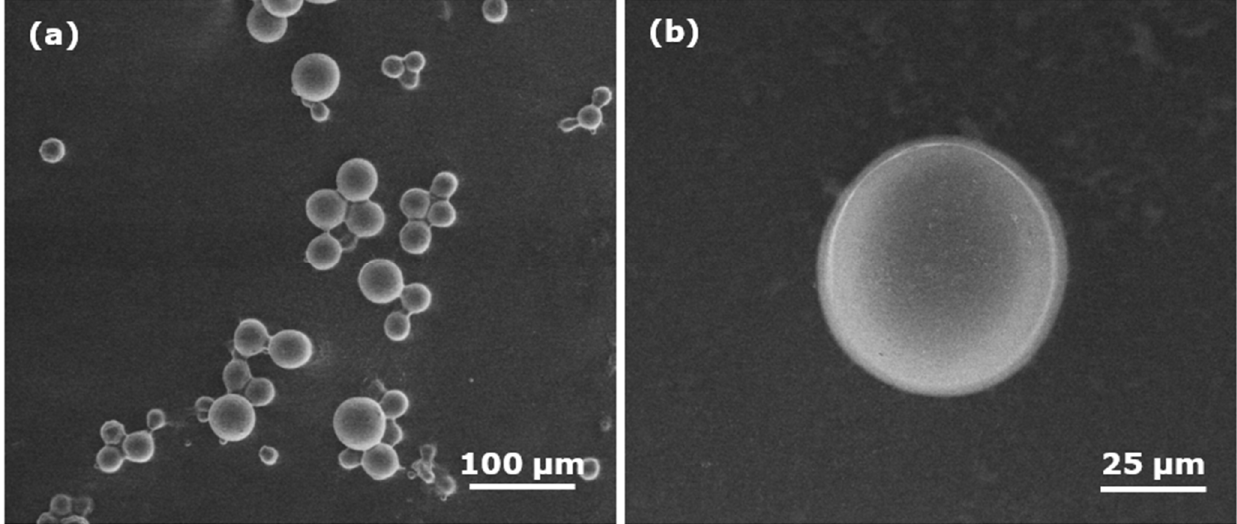
Figure 2. SEM images of polyNIPAm microspheres synthesized using a redox initiator (R1): ( a ) at low magnification (500×); ( b ) at high magnification (2000×).